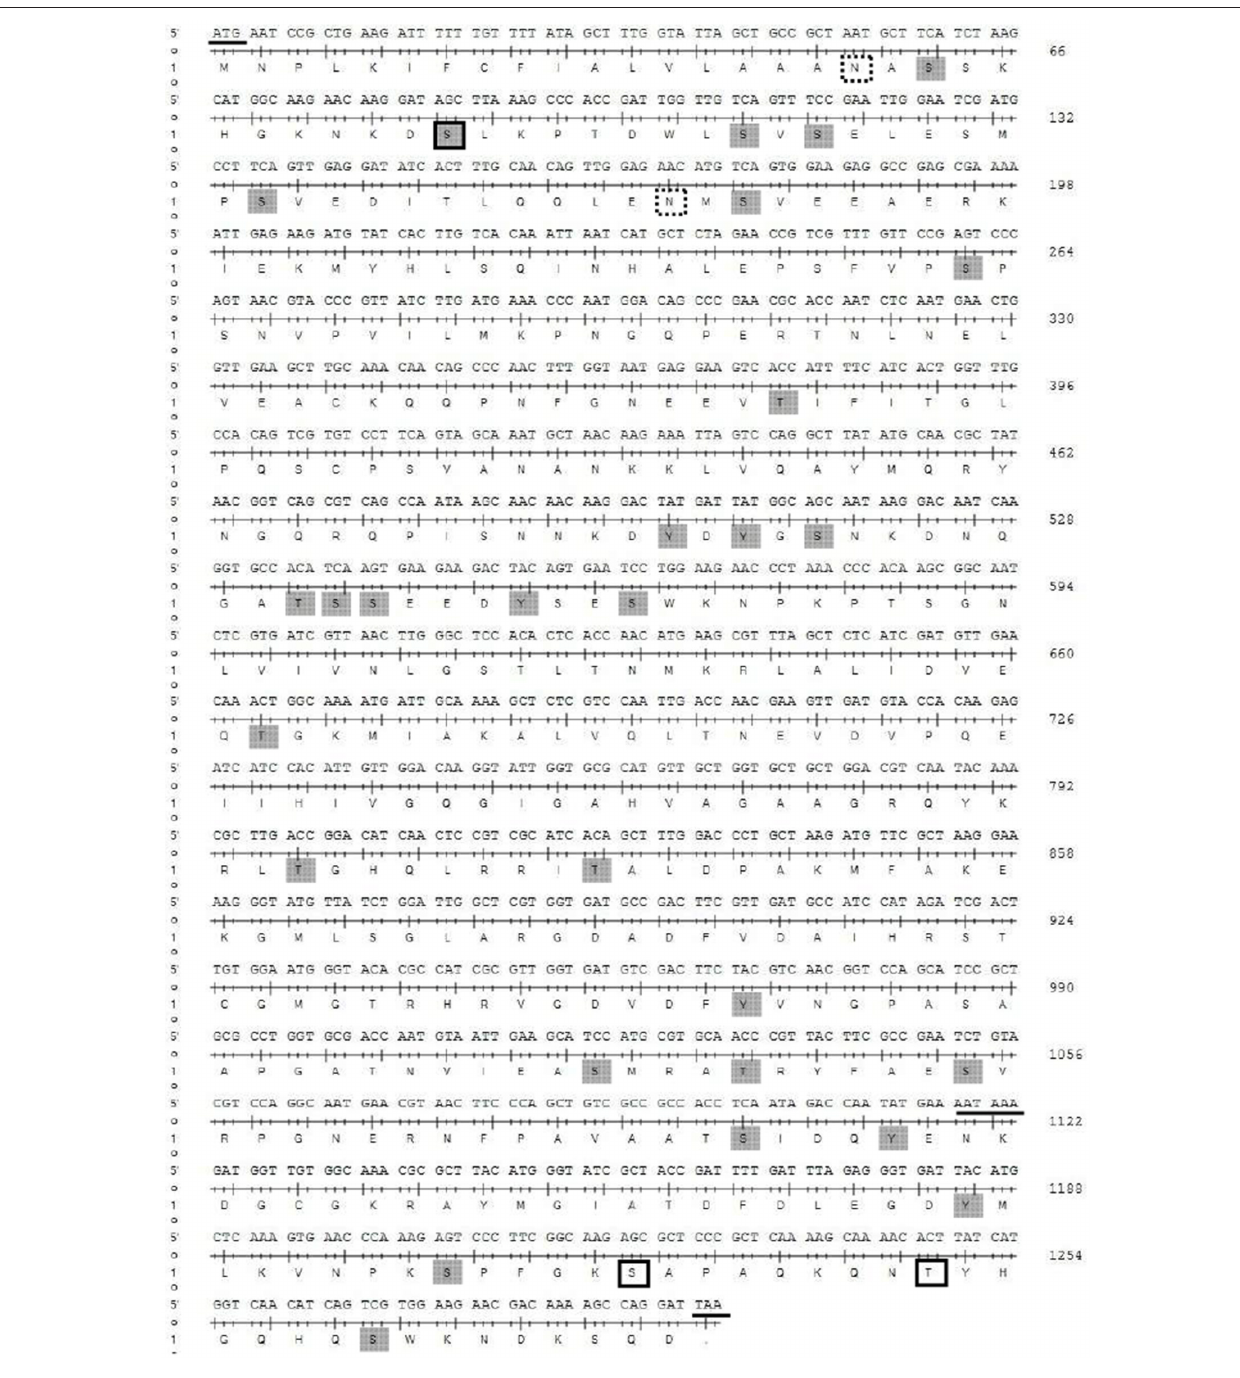
FIGURE 4 | Full length sequence of the Btau YP gene. Underline: initiation codon, tailing signal, and termination codon, framed: glycosylation site, and dashed area: predicted phosphorylation sites.